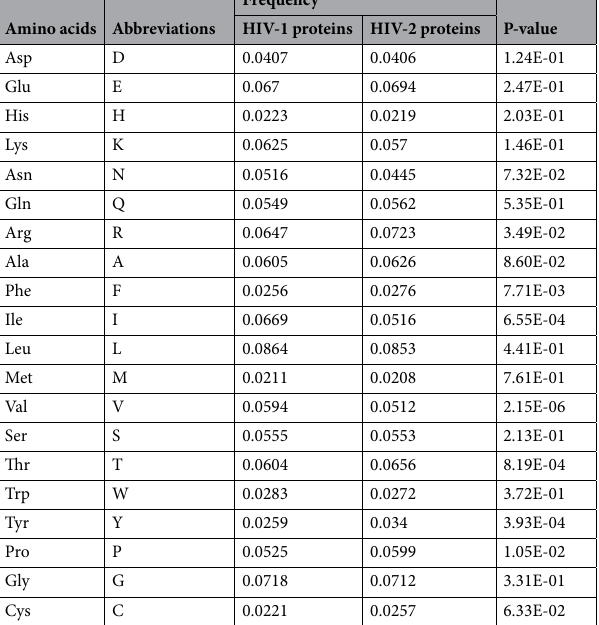
Table 1. The frequencies and P-values of 20 amino acids for 242 HIV-1 proteins and 86 HIV-2 proteins.